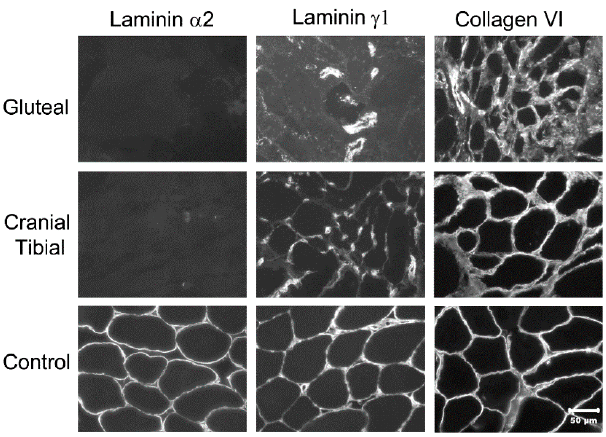
Figure 4. Immunofluorescent labeling of muscle cryosections from gluteal and cranial tibial muscles of affected dog and archived control muscle. Cryosections were incubated with antibodies against laminin α 2, laminin γ 1 and collagen VI. Labeling of basal laminina with antibody against laminin α 2 was not detected in muscles from affected dog but was prominent in archived control muscle. against collagen VI was similar to control. Reduced labeling of laminin γ 1 most likely is a secondary in basal lamina. Bar = 50 µ m for all